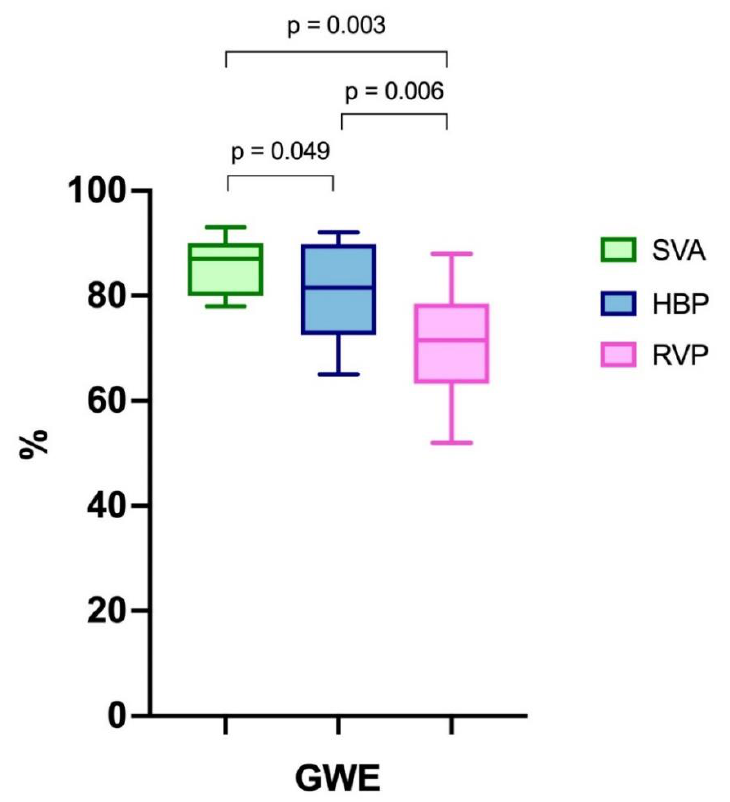
Figure 2. Myocardial work. GWE: global work efficiency. SVA: spontaneous ventricular activation. HBP: His bundle pacing. RVP: right ventricular pacing.